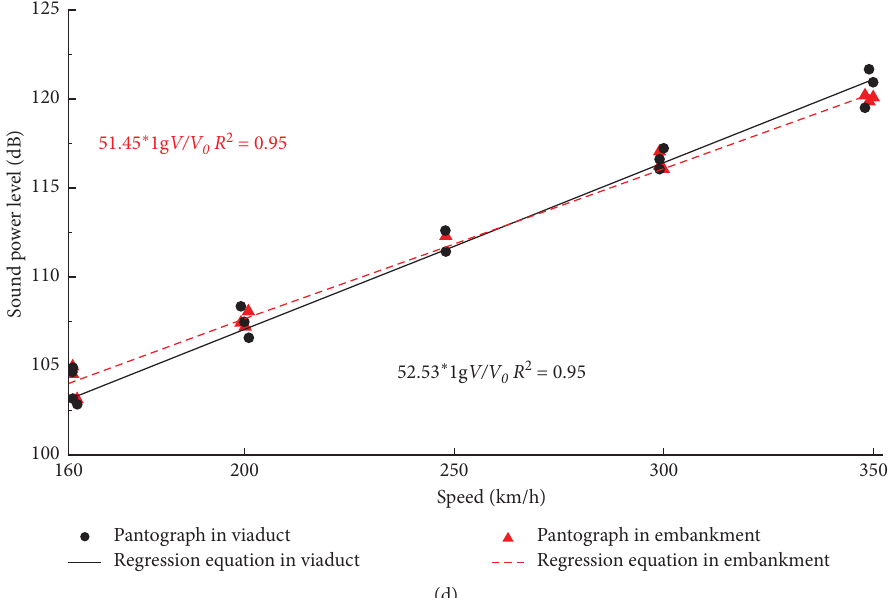
Figure 13: Linear regression of the experimental data in both viaduct and embankment sections. (a) Linear regression of the entire train. (b) Linear regression of the lower parts. (c) Linear regression of bogie region. (d) Linear regression of pantograph